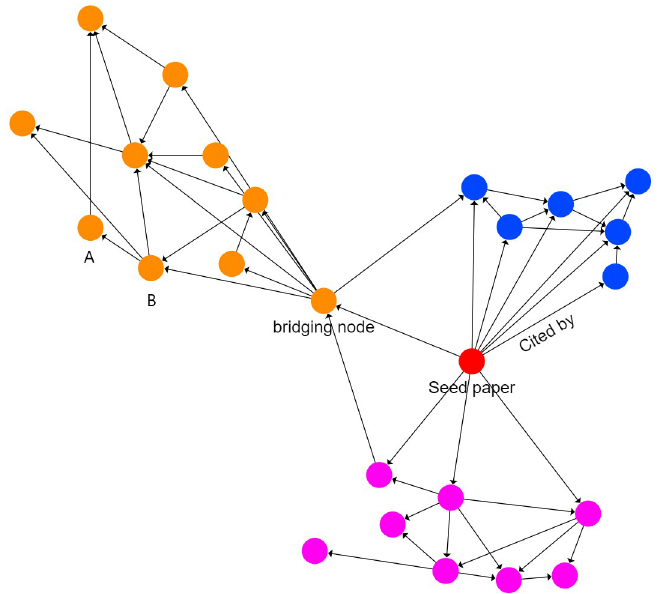
Fig 1. Example of a directed unweighted citation network. The network consists of 25 nodes and 50 edges organized in three communities (colored in blue, orange, and fuchsia). The seed paper (source article) is colored in red. Every node represents a paper whereas every edge between nodes refers to whether that paper is cited by another paper (as indicated by the label “cited by”). An example of bridging node is signaled by the label “bridging node”. Bridging papers serve as links between two or more communities in the